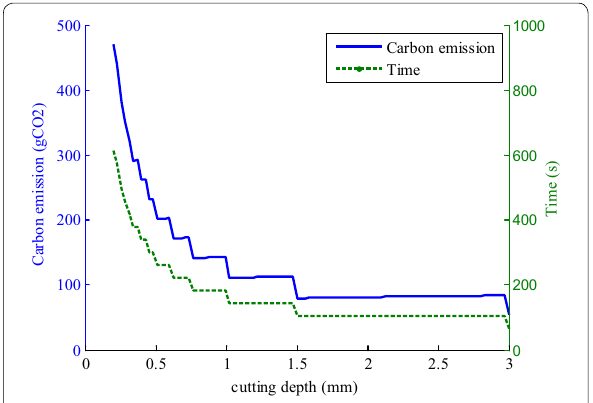
Figure 12 Influence of cutting depth on the optimization